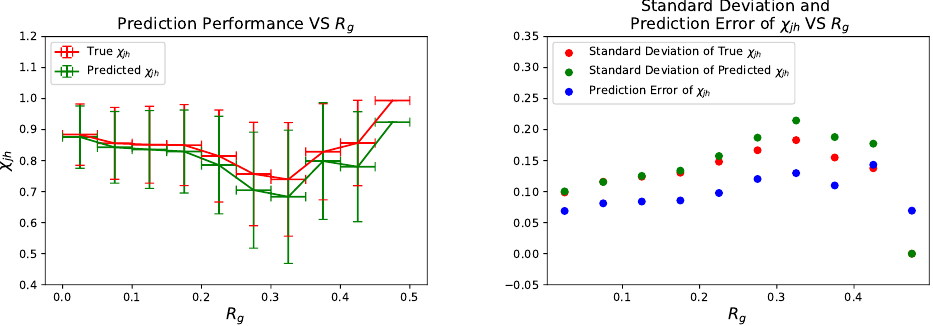
Figure 28 . Prediction Performance (left panel) and Standard Deviation, Prediction Error (right panel) VS R . g